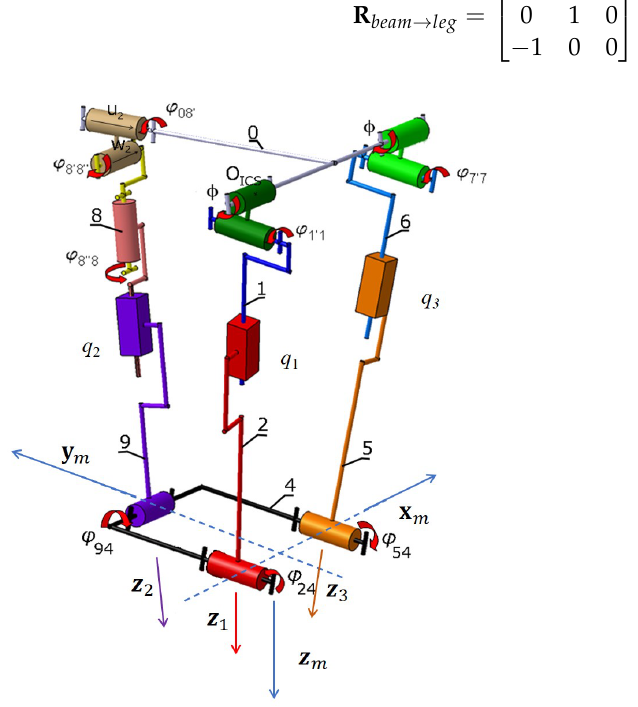
Figure 8. Leg and mobile platform coordinate systems and joint parametrization of Tripteor